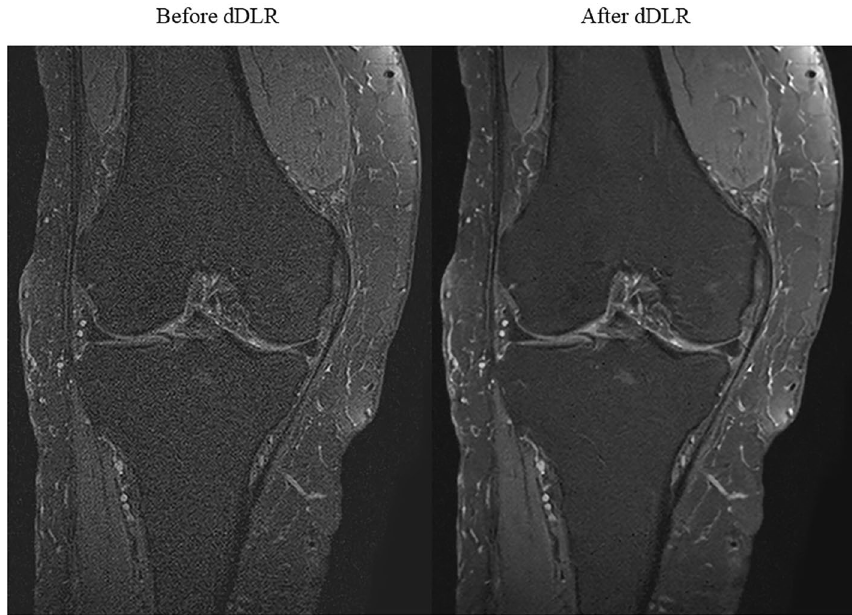
Figure 1. Thin-slice 2D FS-PDWI in a 73-year-old woman before and after the adaptation of dDLR. Images after dDLR are denoised, facilitating observation of the anatomical structures. 2D FS-PDWI indicates 2-dimensional fat saturated-proton density weighted image; dDLR, denoising approach with deep learning- based reconstruction.